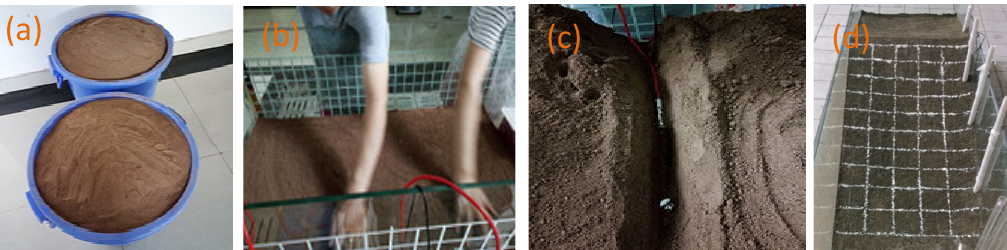
Figure 5. The procedures of tailings dam construction. ( a ) Tailings sample; ( b ) tailings dam construction; ( c ) tailings dam construction; ( d ) displacement monitor.